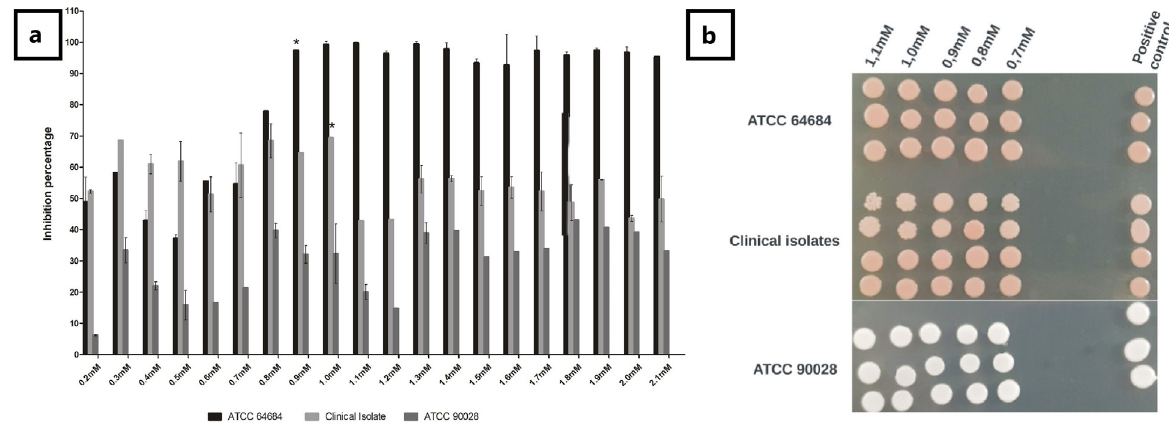
Figure 1. Screening the effect of farnesol concentrations (0.2 mM to 2.1 mM) on planktonic cells of Rhodotorula mucilaginosa : (a) The minimal inhibitory concentration (MIC) based on the metabolic activity (XTT) of R. mucilaginosa ATCC 64684 plus the average for clinical isolates of R. mucilaginosa (CMRP3462 and CMRP3463) and Candida albicans ATCC 90028; (b) Evaluation of the minimal fungicidal concentration (MFC) at concentrations of 1.1 mM, 1.0 mM, 0.9 mM, 0.8 mM and 0.7 mM. Farnesol was not able to inhibit the growth of yeasts, but its action was observed in the interference of metabolic activity. *Statistical difference between strains. All tests were performed in triplicate and on three independent days. Data with a non-normal distribution were expressed as the mean ± standard deviation